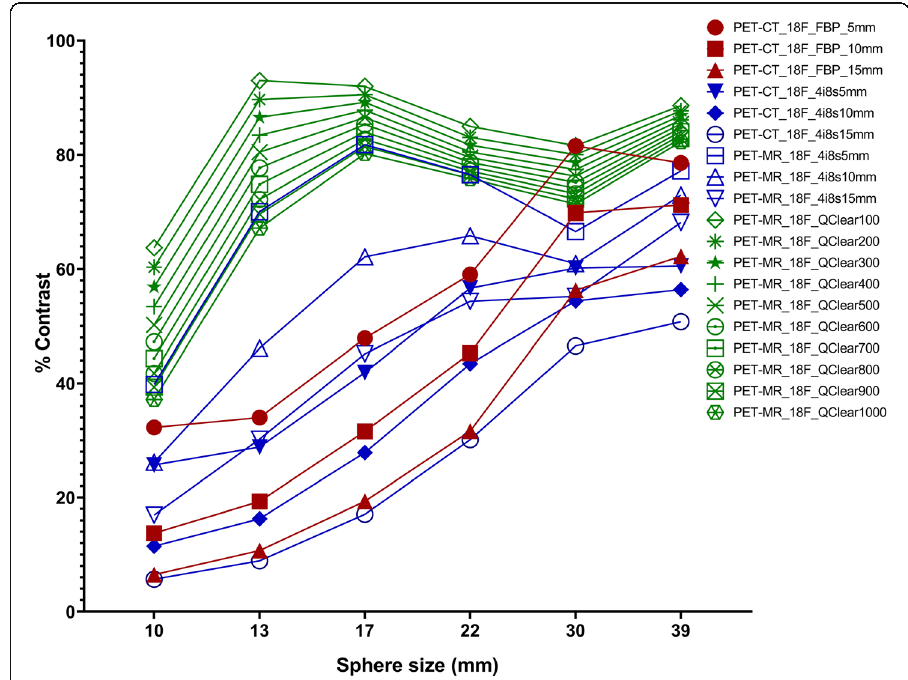
Fig. 1 NEMA phantom measured percentage contrast recovery for all reconstruction methods when using 18 F-solution. Note highest percentage contrast of Q.Clear methods compared with OSEM and FBP